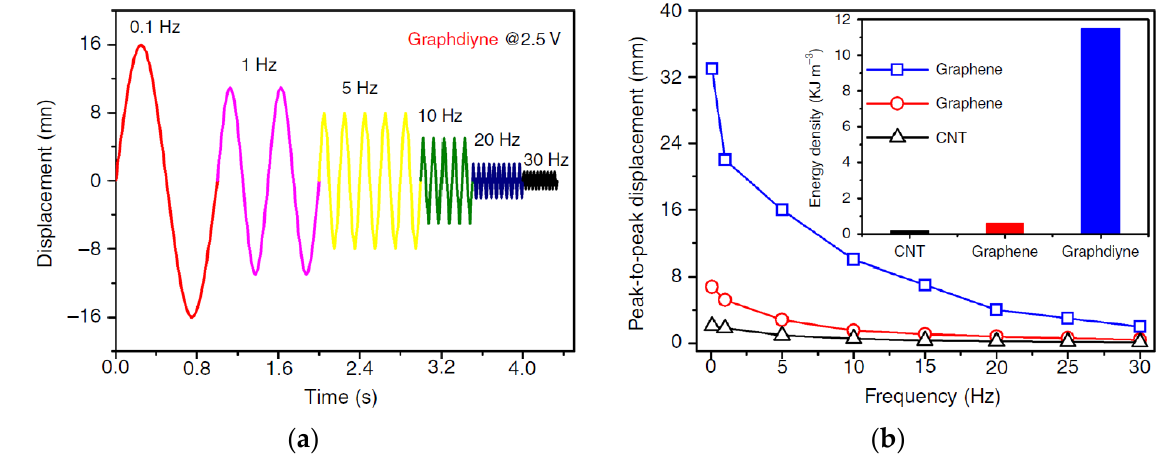
Figure 23. Efficiency of the actuator with the graphdiyne electrodes: ( a ) sinusoidal displacement on time at different frequencies; ( b ) peak-to-peak displacement as a function of frequency for the electrodes of three types (the insert illustrates the comparison of energy densities). Reproduced from [49] with permission from Springer Nature. Copyright 2018.